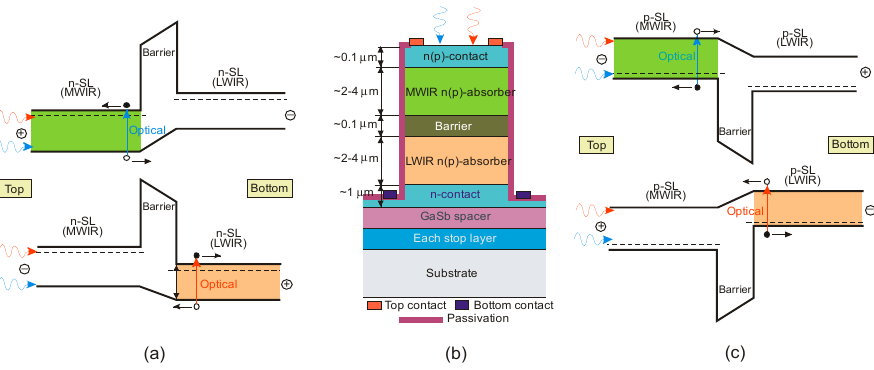
Figure 58. Schematic of nBn ( a ) and pBp ( c ) T2SL dual-band detector operations under forward and reverse bias. Schematic view of dual-band MWIR/LWIR detector architecture is shown in centre ( b ).